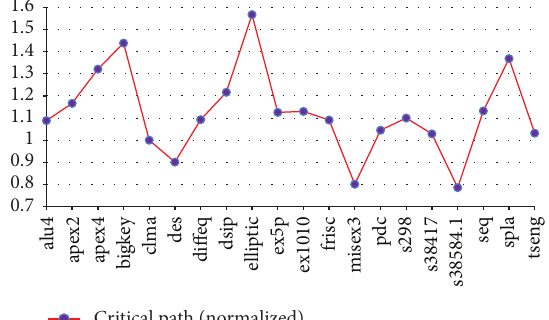
Figure 9: Comparative results of critical path for diffusion based placement algorithm using 1-sigma approach normalized to the respective results from VPRs placement algorithm for cluster size 𝑁 = 4